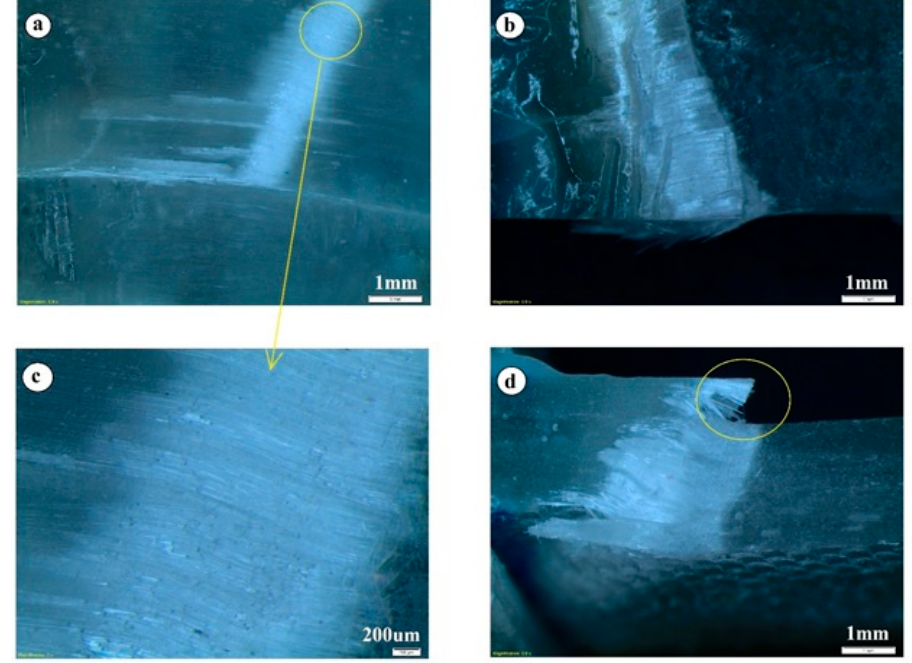
Figure 8. ( a ) Fiber kinking and fiber splitting along the wavy fiber direction in sample A3, ( b ) kink-band view at the free edge, ( c ) magnified fiber kinking view and ( d ) fiber breakage.